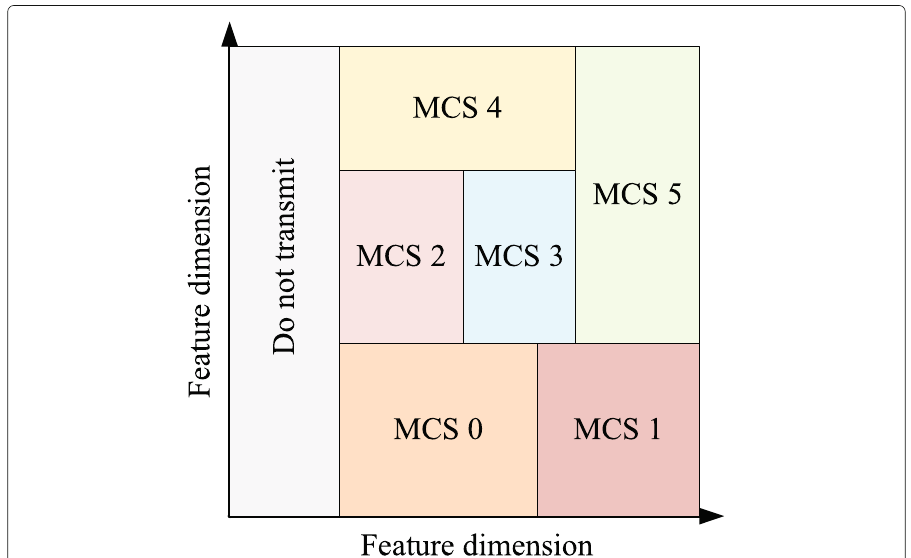
Fig. 2 Partition a two-dimensional feature space into feasible regions for each available